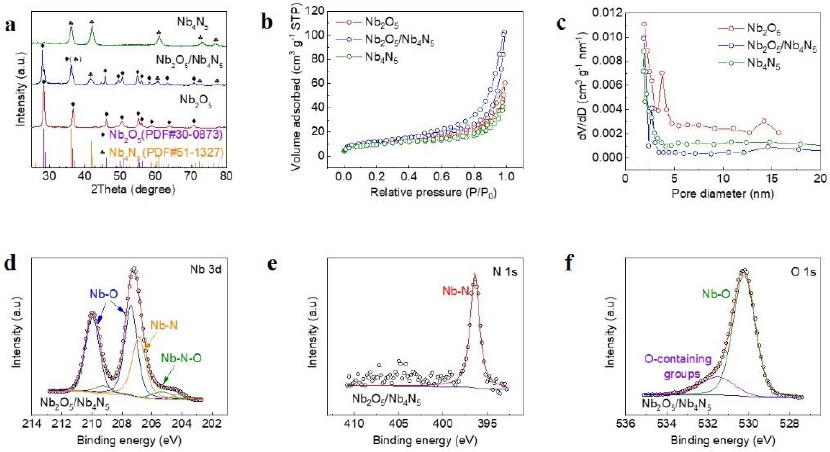
Figure 3. ( a ) XRD patterns; ( b ) N 2 adsorption/desorption isotherms and ( c ) pore distributions of Nb 4 N 5 , Nb 2 O 5 /Nb 4 N 5 and Nb 2 O 5 . XPS spectra of Nb 2 O 5 /Nb 4 N 5 : ( d ) Nb 3d, ( e ) N 1s, and ( f ) O 1s. The LiPS adsorption effect of Nb 2 O 5 /Nb 4 N 5 is evaluated by the LiPS adsorption test using Li 2 S 6 as a representative LiPS (Figure 4a). As is shown in this photograph, the glass bottles starting from left to right contained blank Li 2 S 6 solution, 3DOM Nb 2 O 5 with Li 2 S 6 solution, 3DOM Nb 2 O 5 /Nb 4 N 5 with Li 2 S 6 solution, and 3DOM Nb 4 N 5 with Li 2 S 6 solution, respectively. The orange colour in the solution changed to a lighter brown after 3DOM Nb 4 N 5 was added. Moreover, after 3DOM Nb 2 O 5 is added into the solution, the color of the solution fades intensely and become much more transparent than that of the one with 3DOM Nb 4 N 5 , verifying that Li 2 S 6 adsorption ability of Nb 2 O 5 is much stronger than that of Nb 4 N 5 . At the same time, the solution with Nb 2 O 5 /Nb 4 N 5 became completely colorless, suggesting the synergistic effect of three-dimensionally ordered porous Nb 2 O 5 and the unique catalytic nature of Nb 4 N 5 towards effective trapping of lithium polysulfides. The UV-vis curves comparison displays the vanishing of typical peaks related to S 62 − and S 42 − , demonstrating the strong adsorption of Nb 2 O 5 /Nb 4 N 5 . The highest current response delivered by the Nb 2 O 5 /Nb 4 N 5 electrode can be observed in the LSV test (Figure 4b), indicating the enhanced Li 2 S oxidation kinetics achieved by Nb 2 O 5 /Nb 4 N 5 . This result also implies reduction of the energy barrier of conversion of polysulfides by heterojunction, ensuring that the 3DOM Nb 2 O 5 /Nb 4 N 5 electrodes promoted catalytic process of sulfur [31]. The TGA graph was performed as shown in Figure S2. The S content can reach 73% owing to the abundant hierarchical pore structure. To assess the enhanced electrochemical kinet- ics in depth, cyclic voltammetry (CV) characterization of the symmetric cells containing the 0.2 M Li 2 S 6 electrolyte are performed with the scan rate of 1 mV s −1 (Figure 4c). The CV profile of 3DOM Nb 2 O 5 /Nb 4 N 5 exhibits excellent reversibility, with two pairs of redox peaks (−0.03, 0.03 and −0.22, 0.22 V) probed. However, the CV of 3DOM Nb 2 O 5 and Nb 4 N 5 only obtains one pair of broadened redox reaction peaks, which is at −0.19 V and 0.19 V, separately. Moreover, the peak intensity of Nb 2 O 5 /Nb 4 N 5 is higher than that of Nb 2 O 5 and Nb 4 N 5 , indicating the limited transformation of polysulfides on the bare surface of Nb 2 O 5 /Nb 4 N 5 heterojunction. The initial three CV cycles (Figure 4d) of the Nb 2 O 5 /Nb 4 N 5 heterojunction are perfectly overlapped, suggesting excellent cycling stabil- ity. As is widely accepted by the scientific community, the transformation from Li 2 S 4 to Li 2 S contributes almost 75% of discharge capacity. As a result, the Li 2 S deposition test is conducted, as shown in Figure 4e. It can be observed from Figure 4e that nucleation peak response of the heterostructure is earlier than that of Nb 2 O 5 and Nb 4 N 5 , and nucleation capacity of 3DOM Nb 2 O 5 /Nb 4 N 5 (283 mAh g −1 ) is highest among the three samples. This may lead to a lower overpotential of the nucleation, electrocatalytic conversion of Li 2 S, and adsorbent to polysulfide species [32].